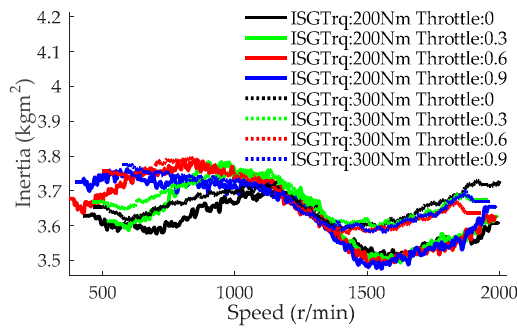
Figure 10. Total moment of inertia.